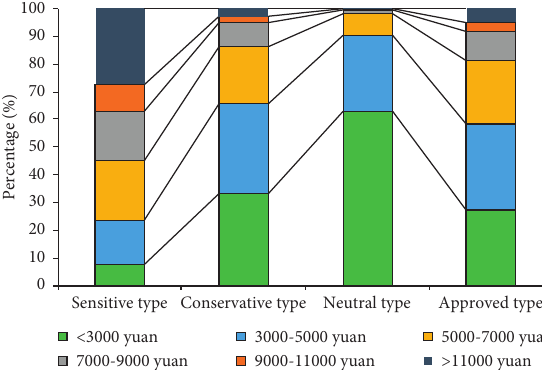
Figure 11: Income of drivers in the four segments.